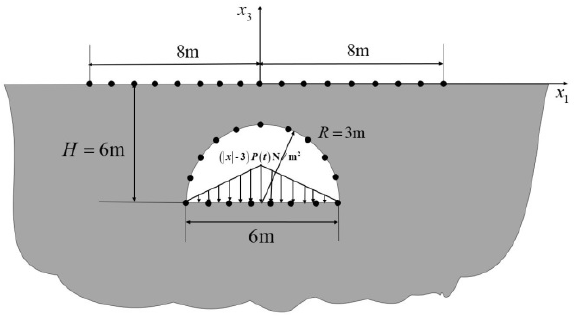
Figure 10. Schematic sketch of the semi-infinite domain tunnel.